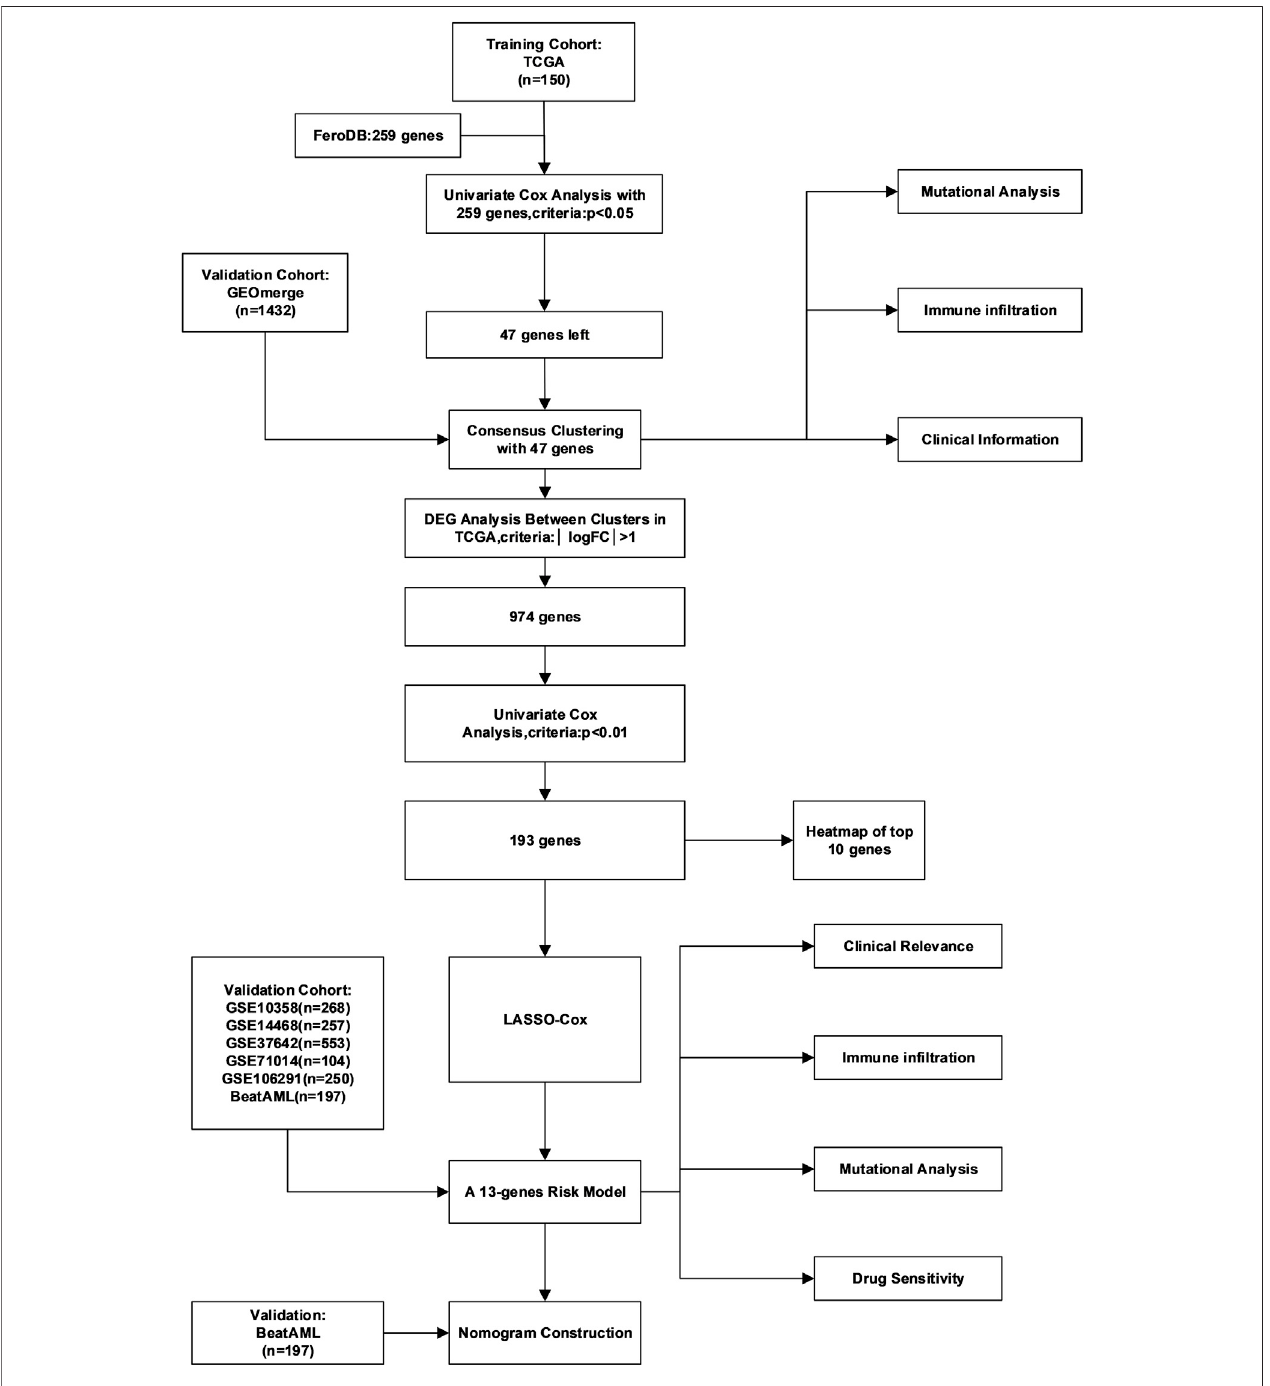
FIGURE 1 | Detailed fl ow chart of the whole